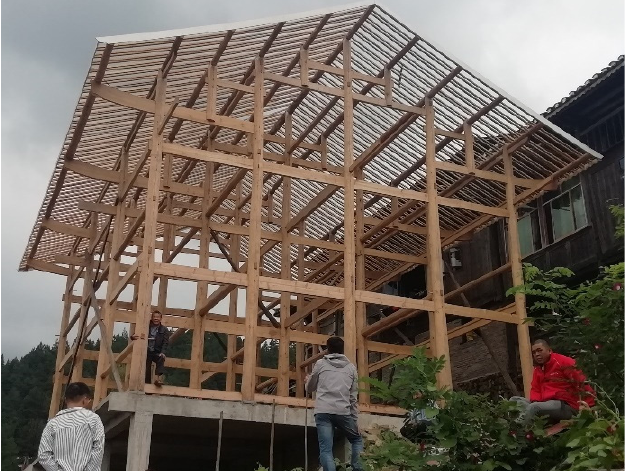
Figure 1. Structure of traditional dwellings in Southeast Guizhou.